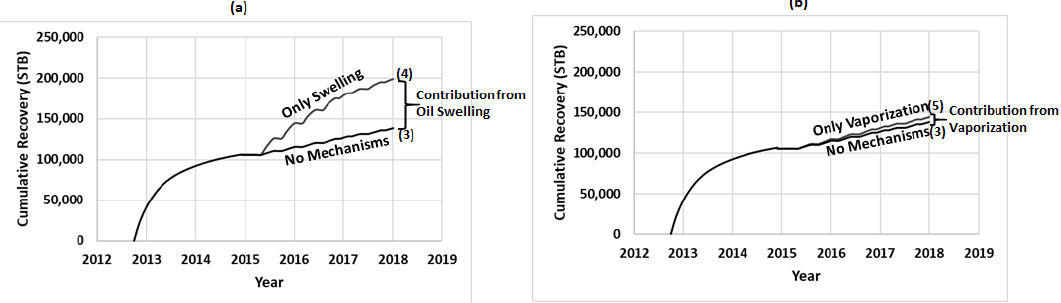
Figure 12. Graphical explanation showing how to find the contribution of ( a ) oil swelling and ( b ) vaporization. ( b ) vaporization.